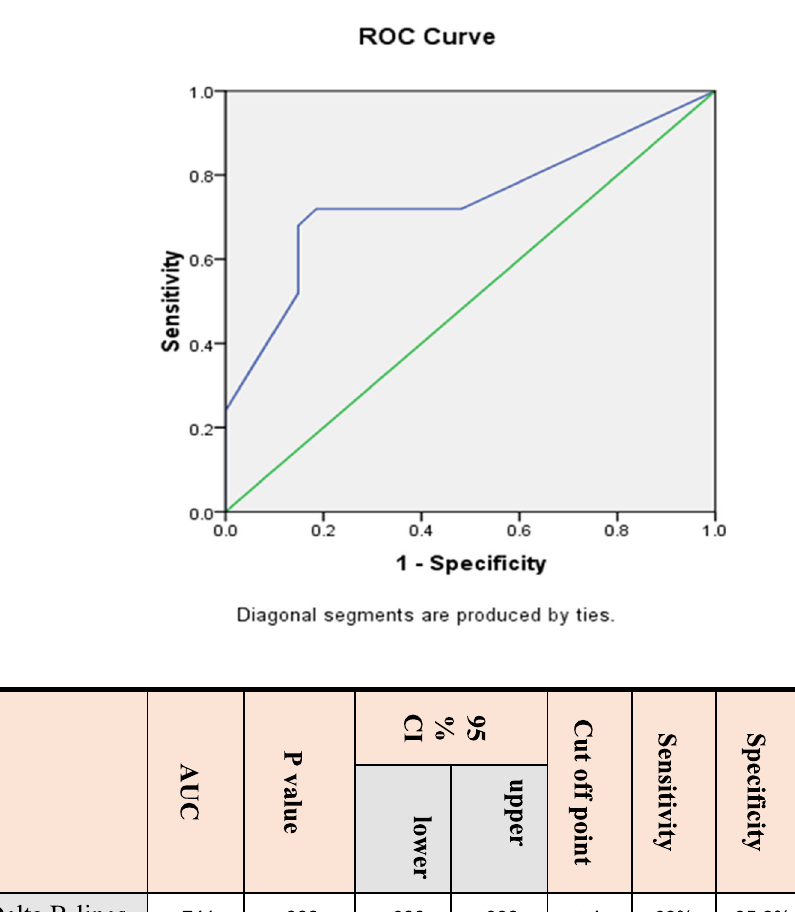
* p value is significant